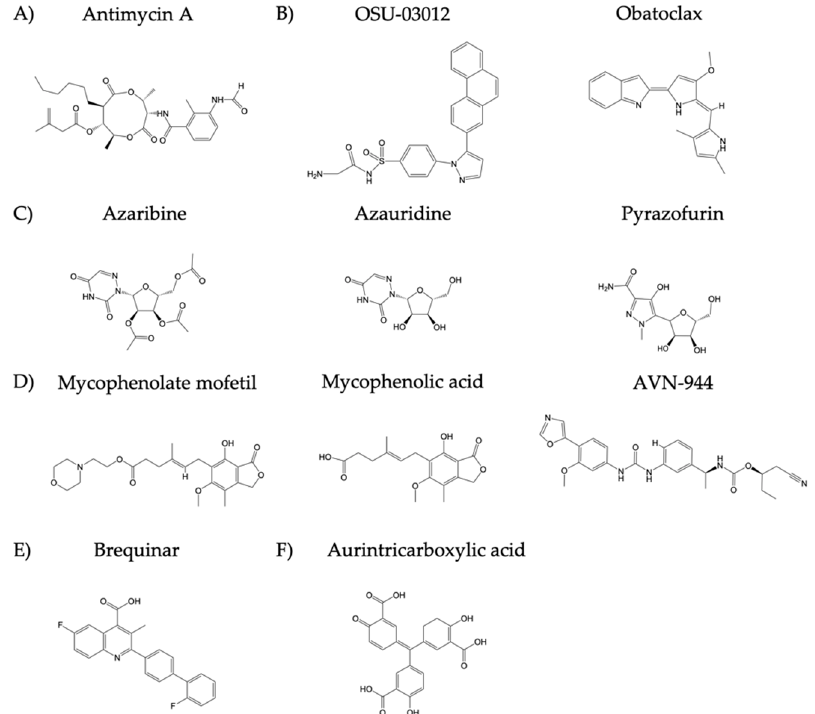
Figure 1. Chemical structure of the compounds: Groups of compounds include ( A ) inhibitors of adenosine triphosphate (ATP) synthesis (Antimycin A), ( B ) apoptosis inducers (OSU-03012 and Obatoclax), ( C ) inhibitors of orotidine monophosphate decarboxylase (OMPD), which catalyzes key